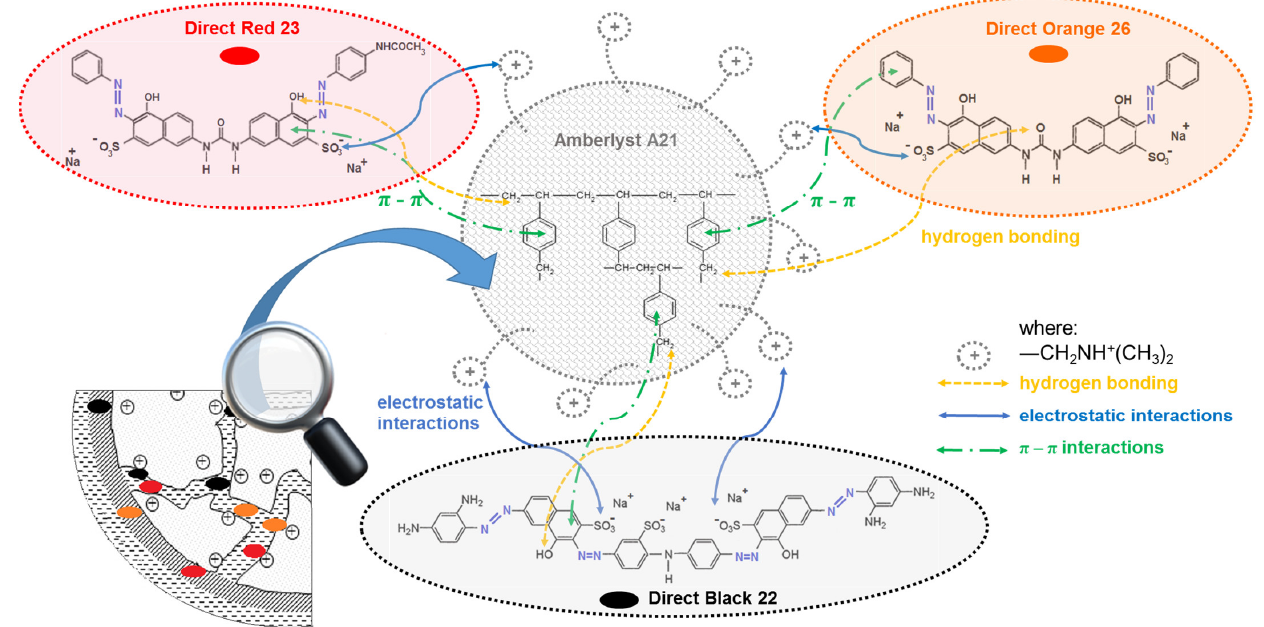
Figure 3. Possible interactions of direct dyes with A-21